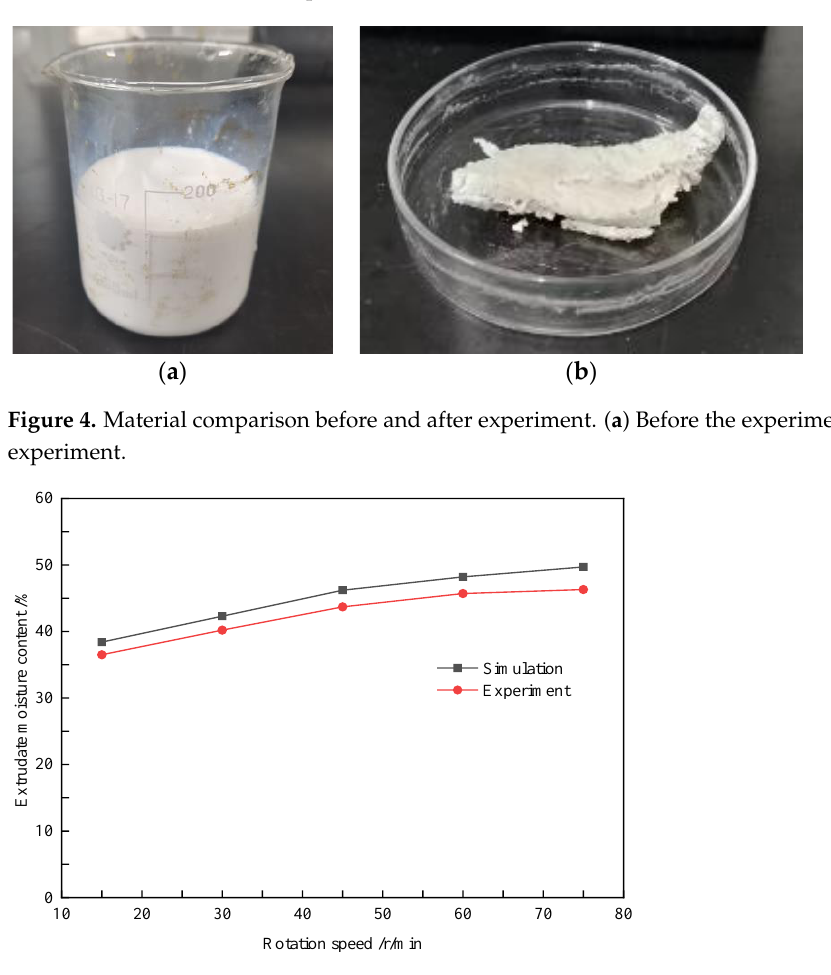
Figure 5. Comparison of simulation and test results .